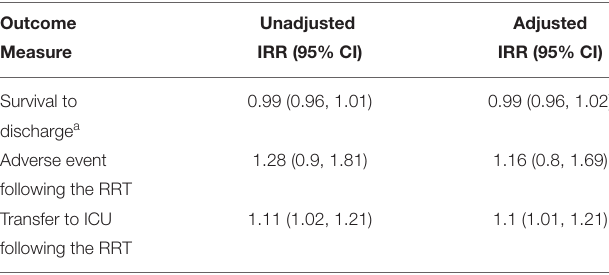
TABLE 4 | Outcome measures stratified by the category of interpreter use per day of hospital stay during 412 RRTs and 281 hospitalizations from 229 patients who use LOE in the study